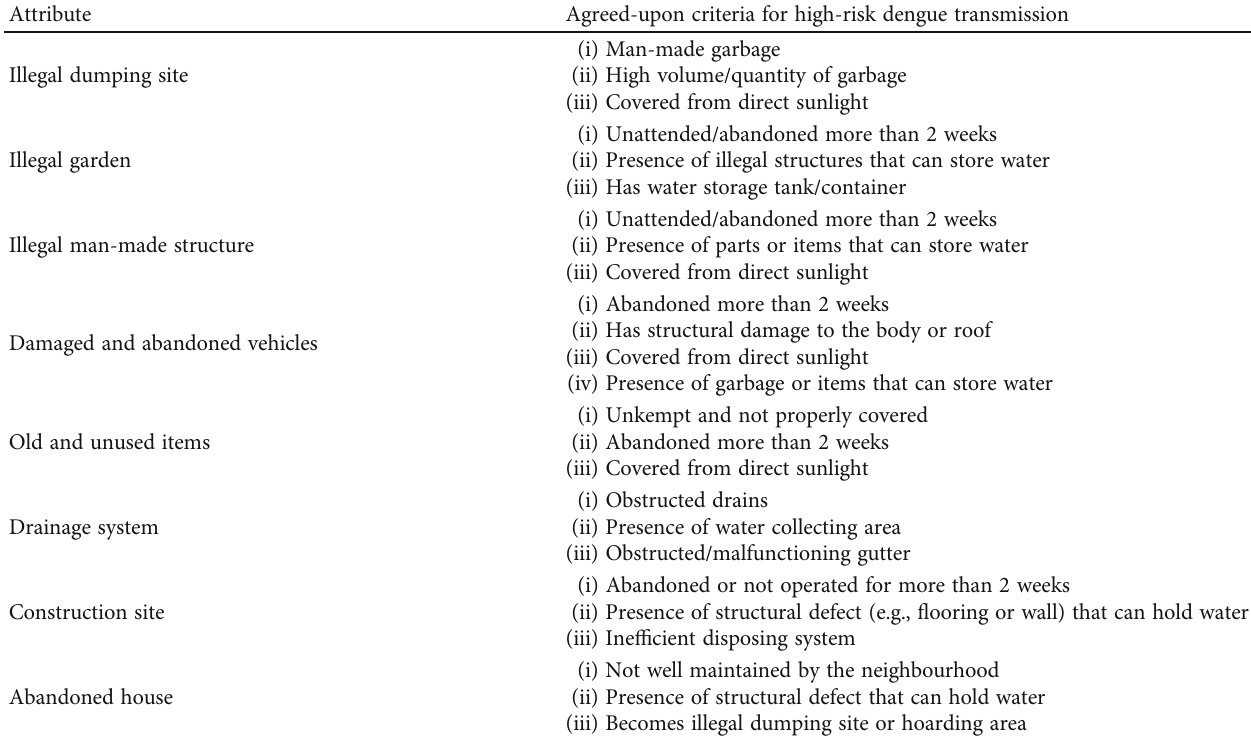
Table 3: Expert consensus of criteria for each risk